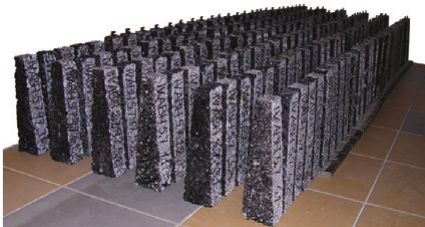
Fig. 3. AC 16 mixtures testing specimens for the determination of stiffness modulus and fatigue